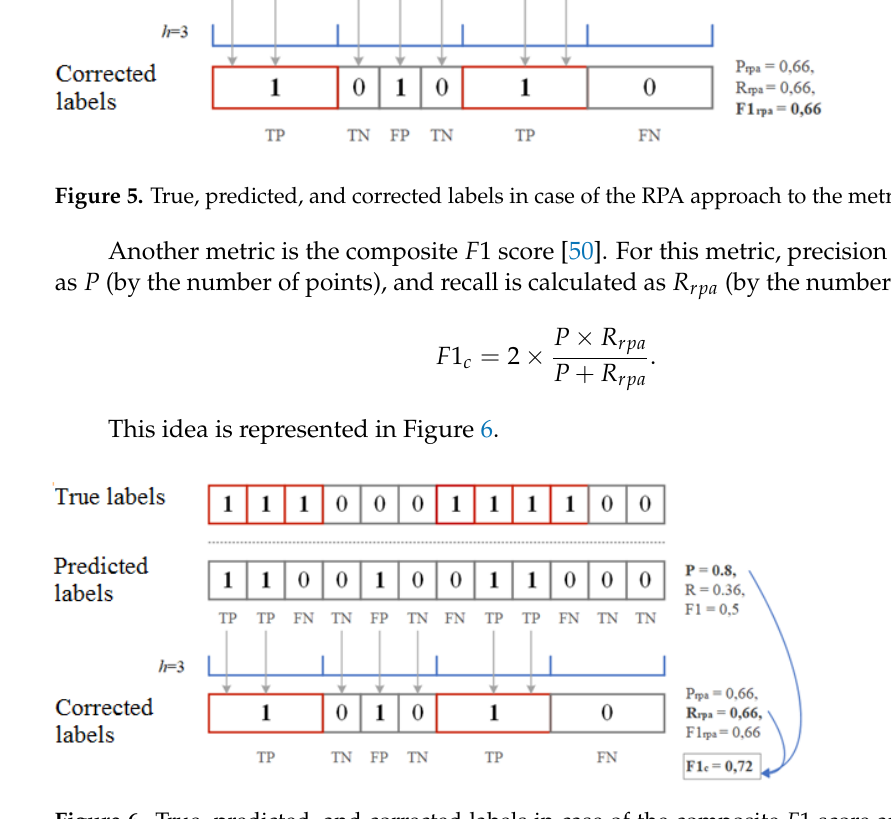
Figure 6. True, predicted, and corrected labels in case of the composite F 1 score approach to the metrics